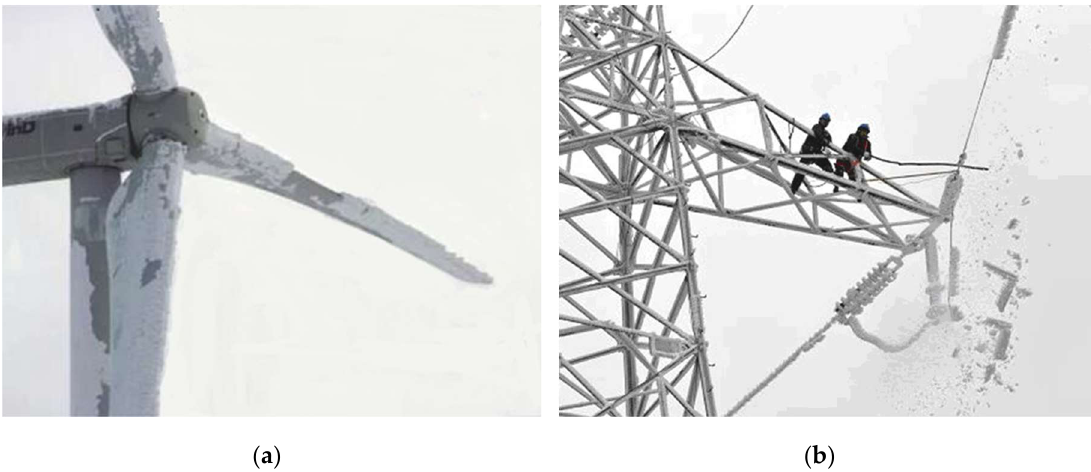
Figure 1. Serious atmospheric icing: ( a ) Icing on wind turbines; ( b ) icing on the transmission line.